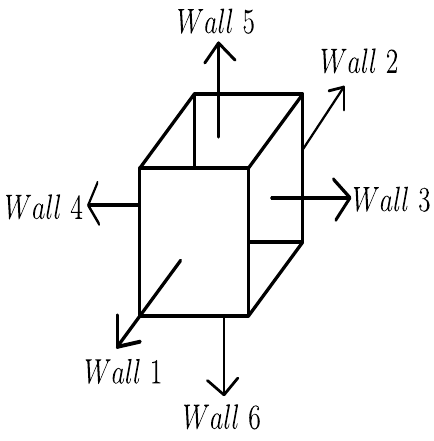
Figure 3. Numbering of the walls in a thermal